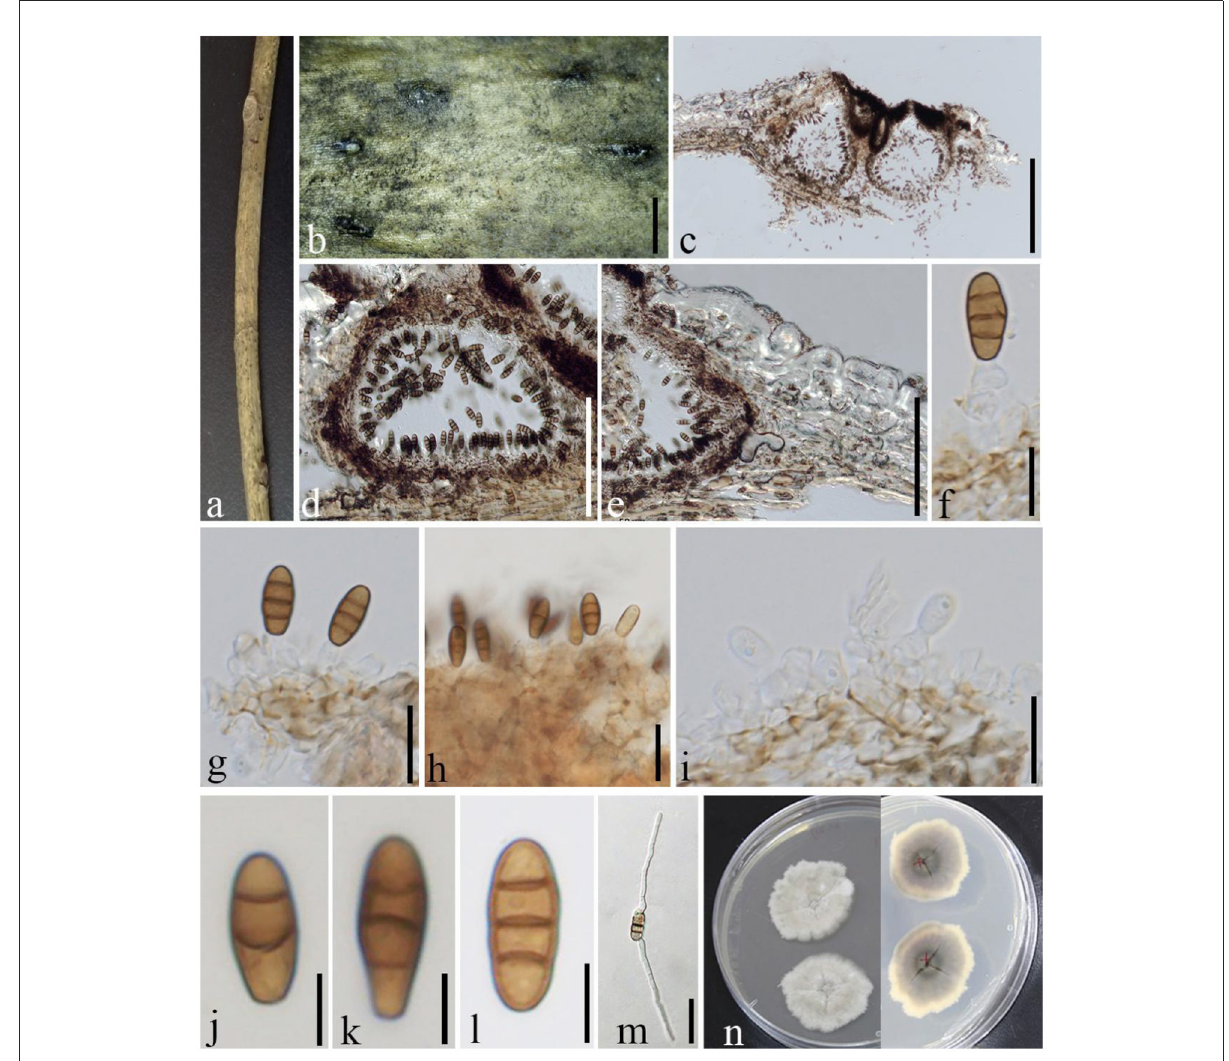
FIGURE10 Phragmocamarosporium qujingensis (GMB1384, holotype). (a) Dead branch of M. grandiflora . (b) Appearance of ascomata on host. (c,d) Vertical sections of conidiomata. (e) Peridium. (f–i) Conidia attached to conidiogenous cells. (j–l) Conidia. (m) Germinated conidium. (n) Seven-day-old colonies incubated at 28 ◦ C on PDA. Scale bars: (b) = 1,000, (c) = 200, (d) = 100, (e) = 100, (f,g,i) = 10, (h,m) = 15, and (j–l) = 5 µ m.